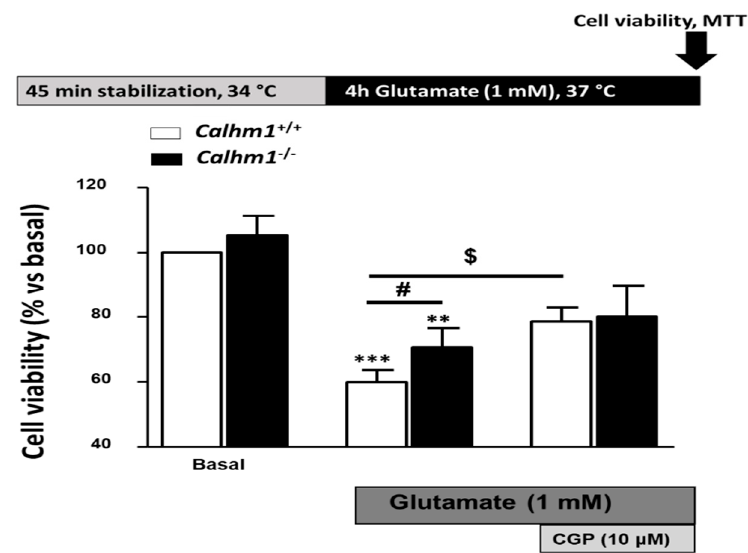
Figure2. Figure 2. CALHM1 ablation results beneficial against glutamate-induced excitotoxicity and abolishes